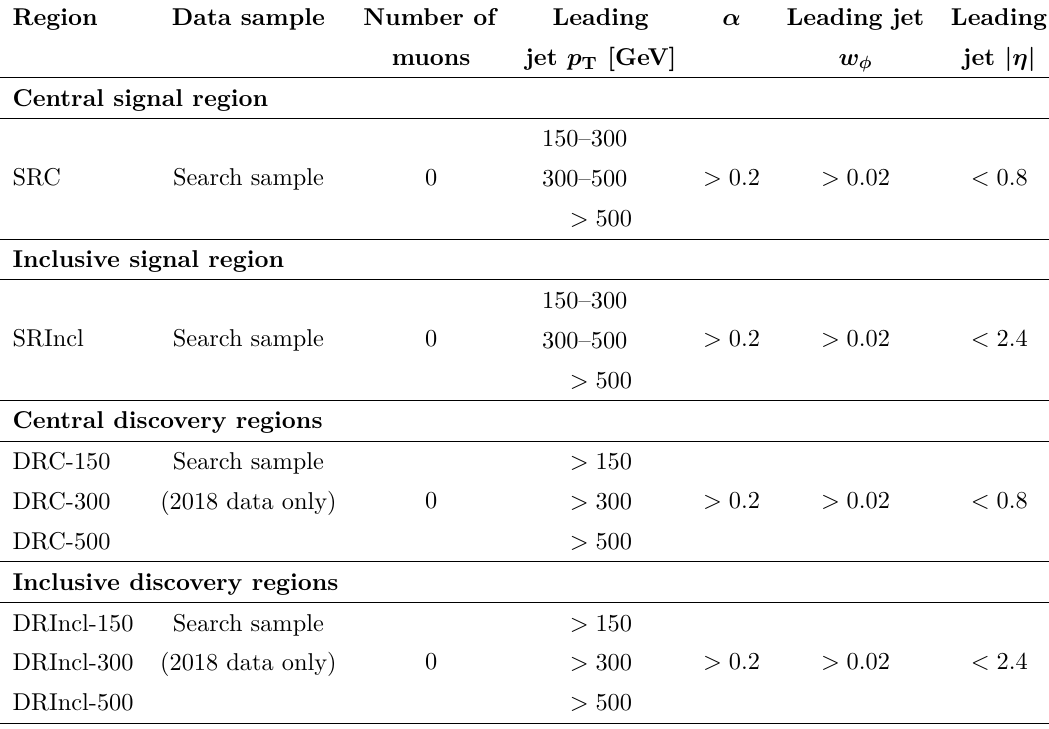
Table 2 . Overview of the signal and discovery regions. These regions are divided into two sets; one set imposes an | η | < 0 . 8 requirement on the leading jet in the event, while the other set accepts leading jets within | η | < 2 . 4 . Events for which α cannot be determined are included in the SRs and